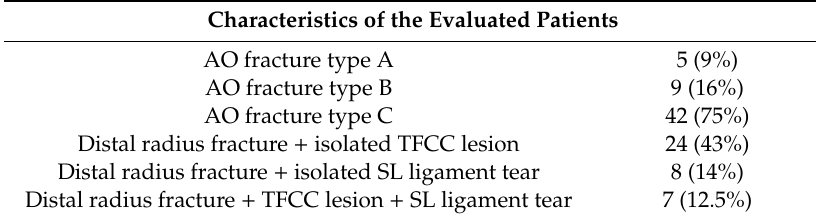
Table 1. Fracture classification and concomitant injuries.